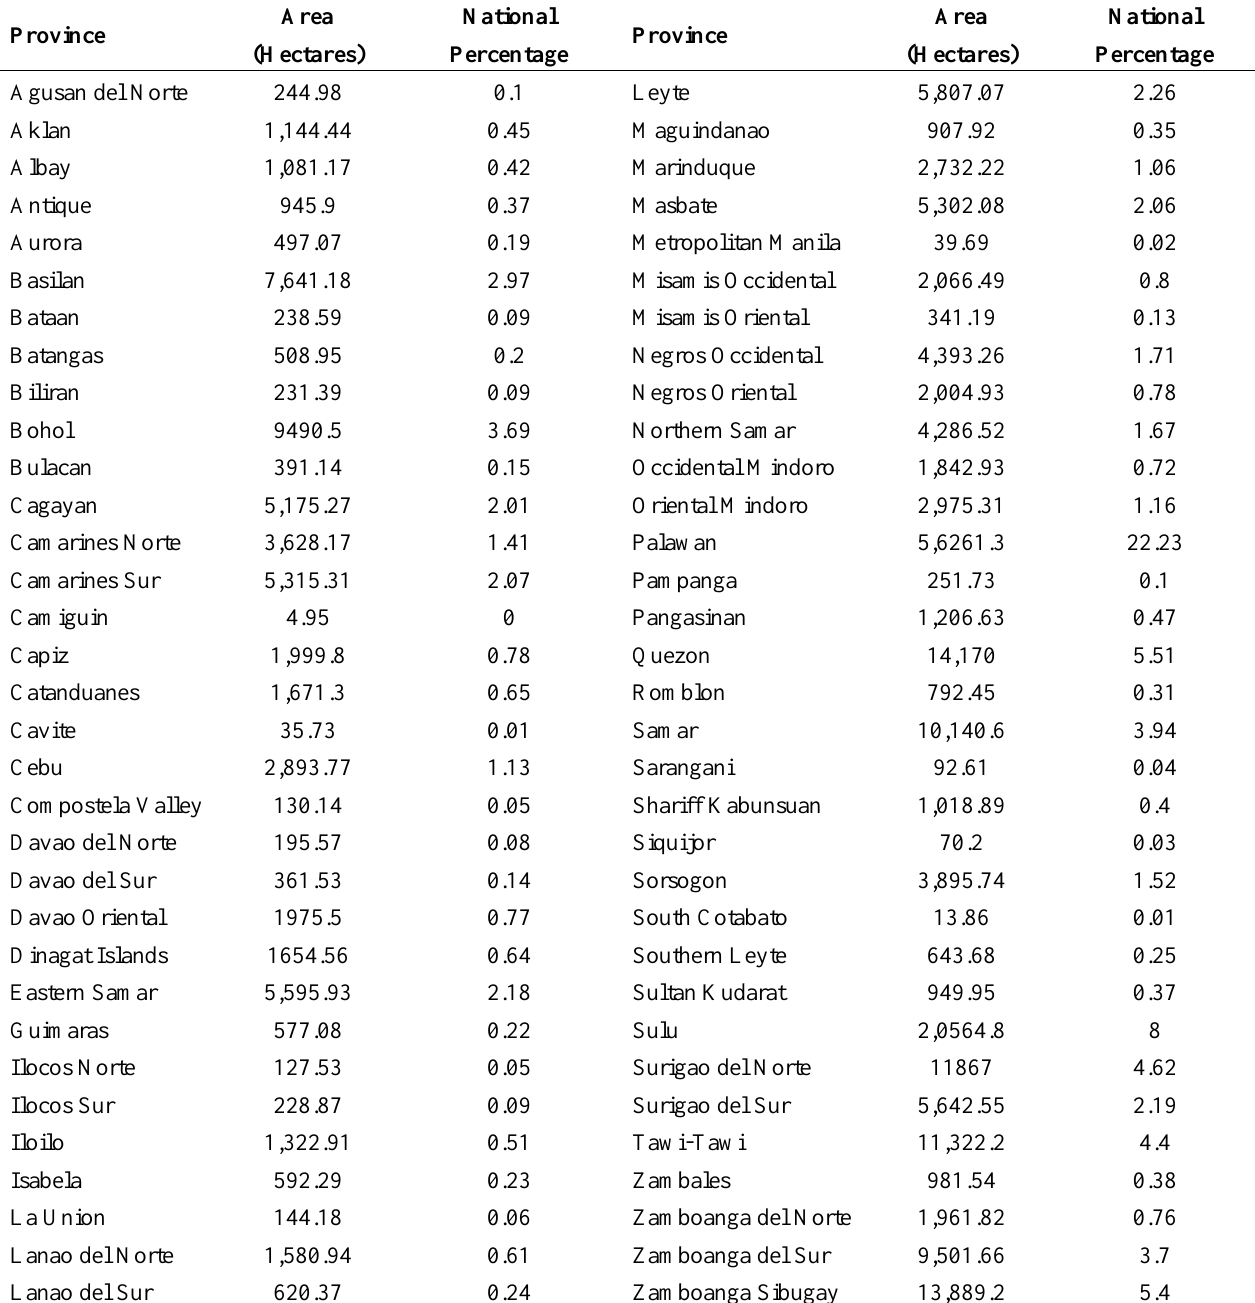
Table 1. Mangrove areal extent by